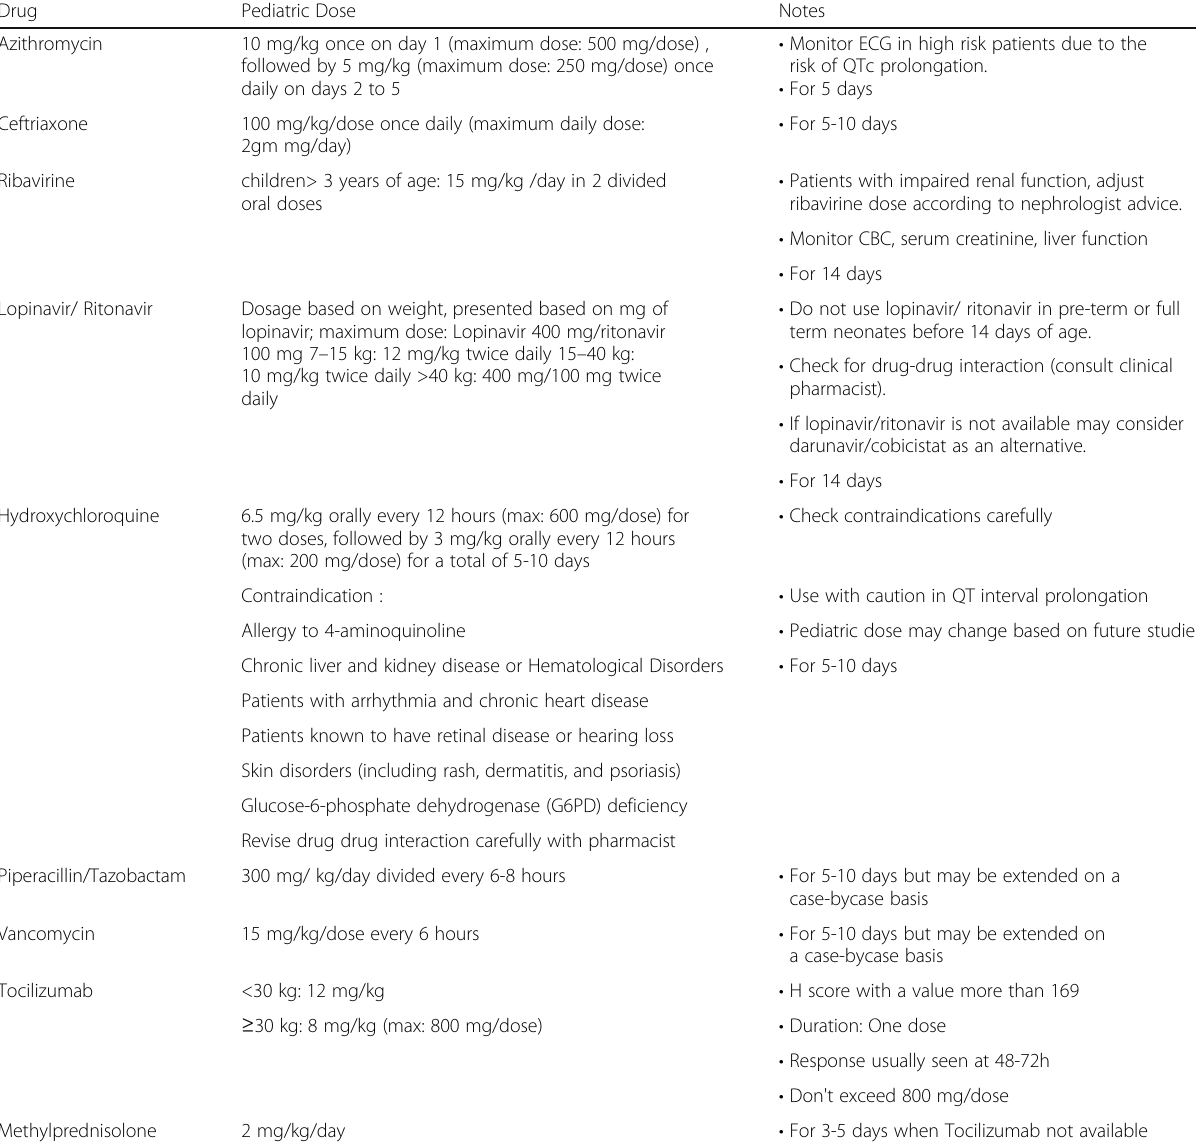
Table 2 Pediatric drug doses of used medications Drug Pediatric